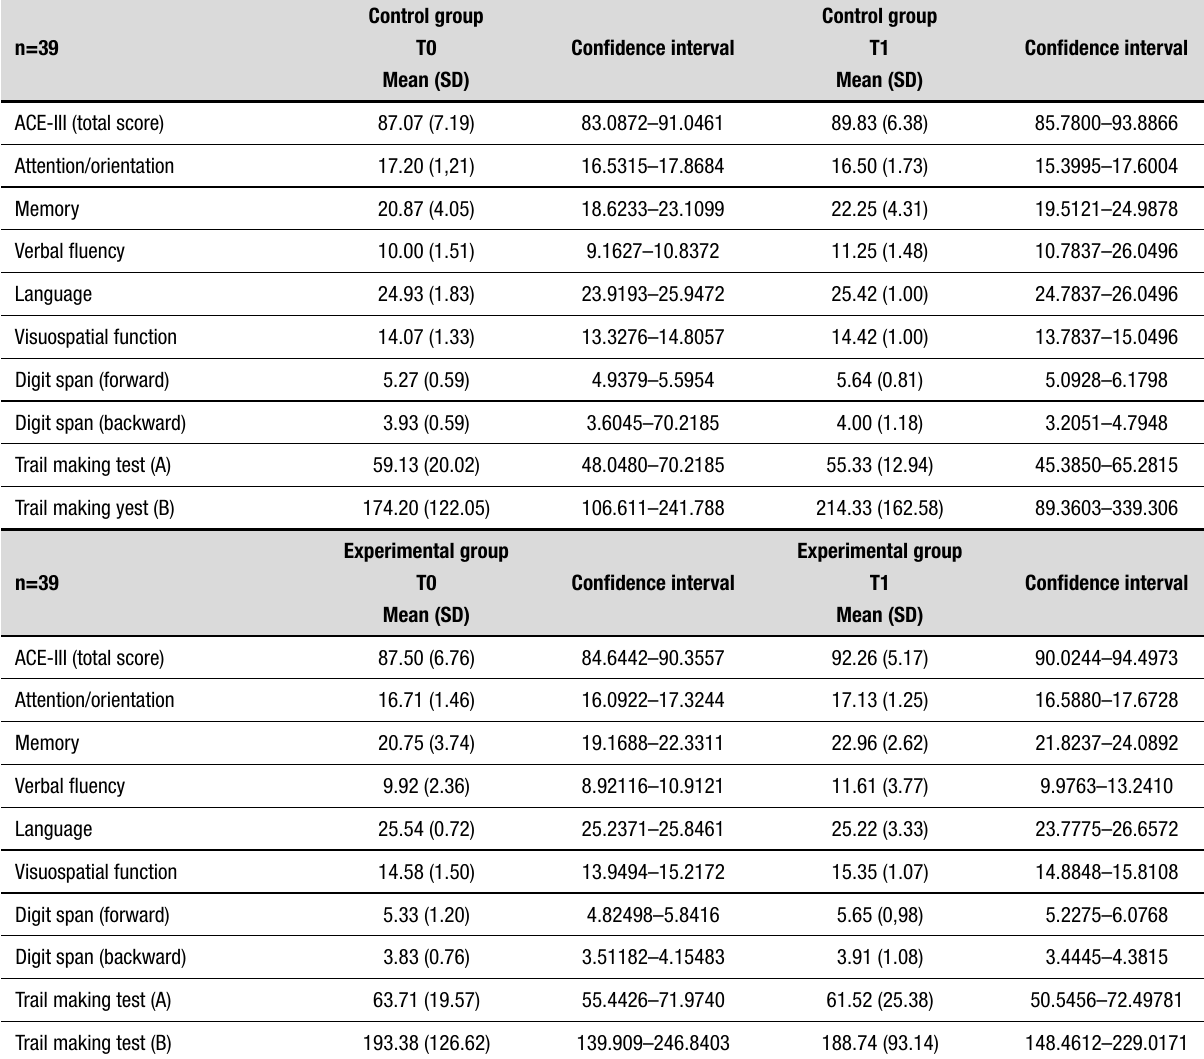
Table 2. Neurocognitive performances in the control and experimental groups at baseline (T0) and retest (T1).